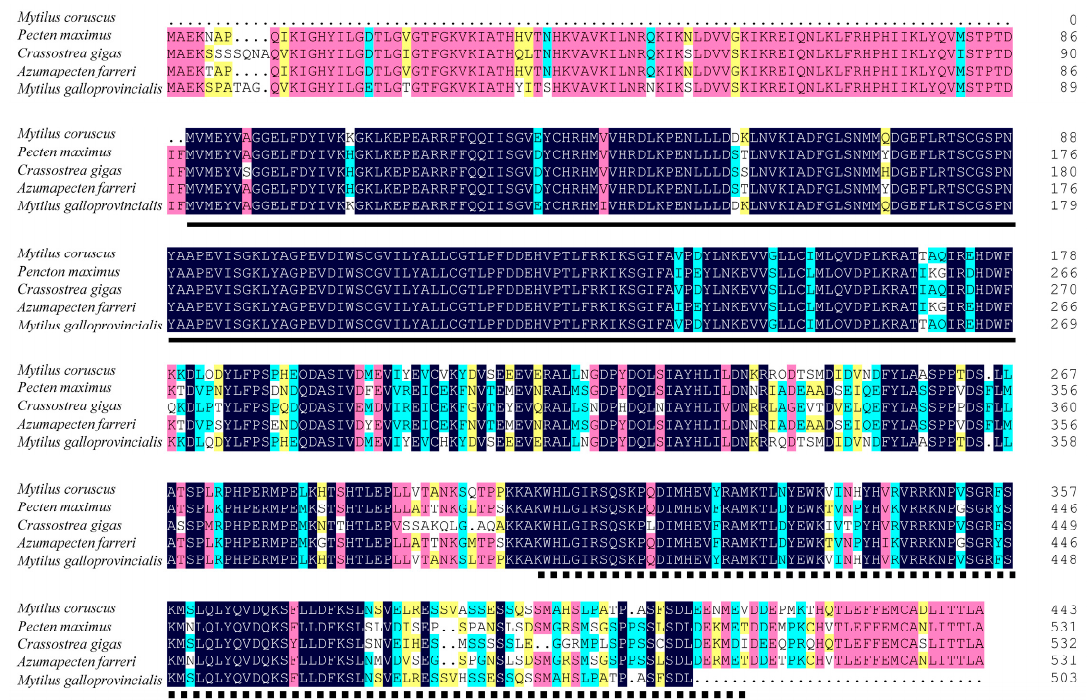
Figure 5. The multiple sequence alignment of McAMPK α with other mollusks. The dark blue area: complete similarity; the pink area: 75% similarity; the blue area: 50% similarity; and the yellow area: more than 33% similarity. The same as below. The underlined area represents the S_TKc domain. The square-dotted line represents the adenylate sensor domain. The accession number of the AMPK α sequence used: Pencten maximus (XP_033736754.1), Crassostrea gigas (XP_034311308.1), Azumapecten farreri (QFR39800.1), and Mytilus galloprovincialis (VDI56011.1).